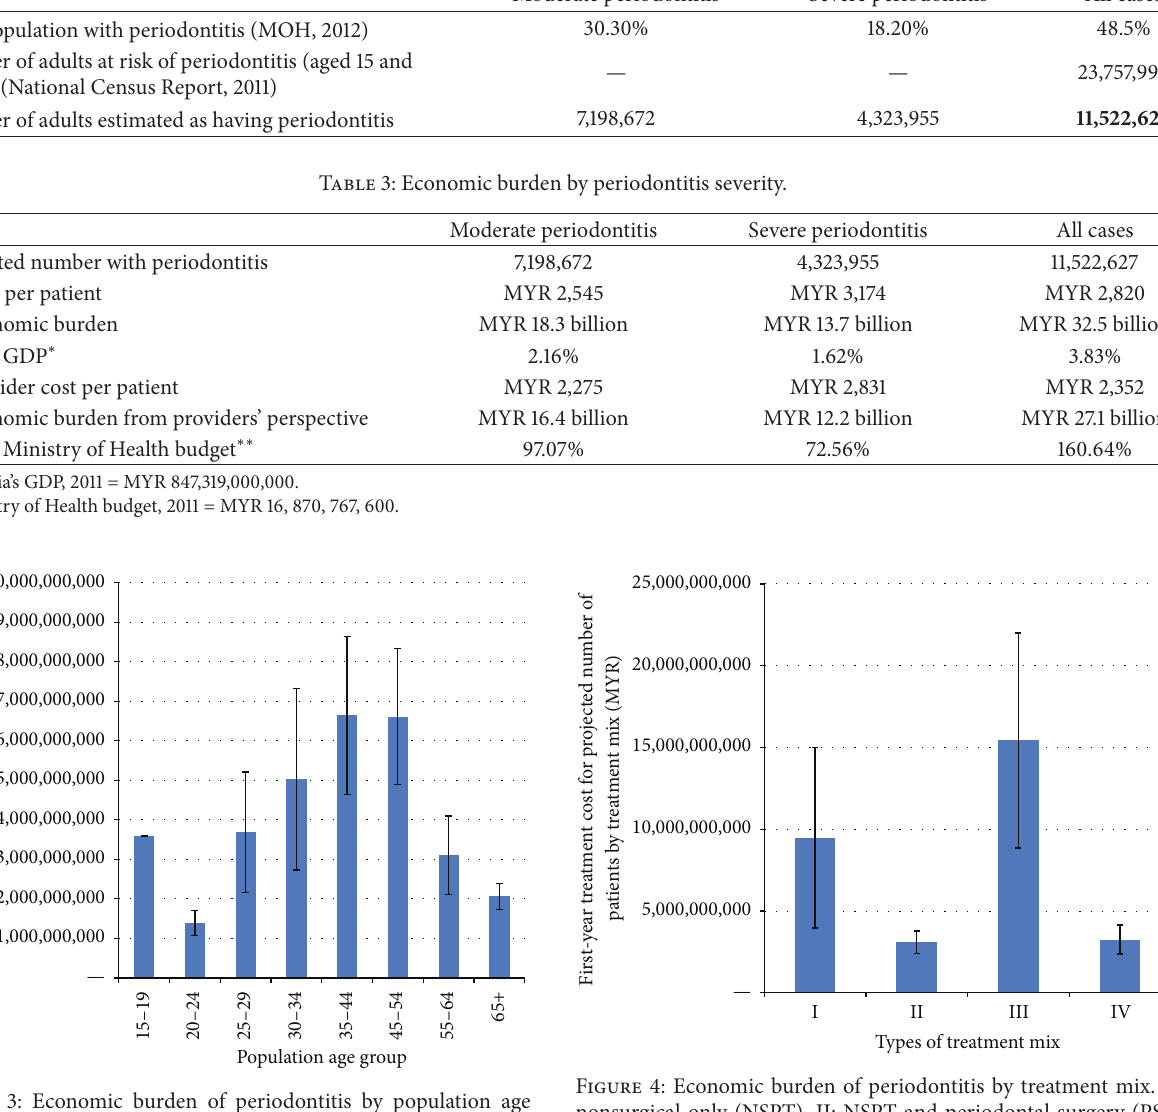
Figure 3: Economic burden of periodontitis by population age group.